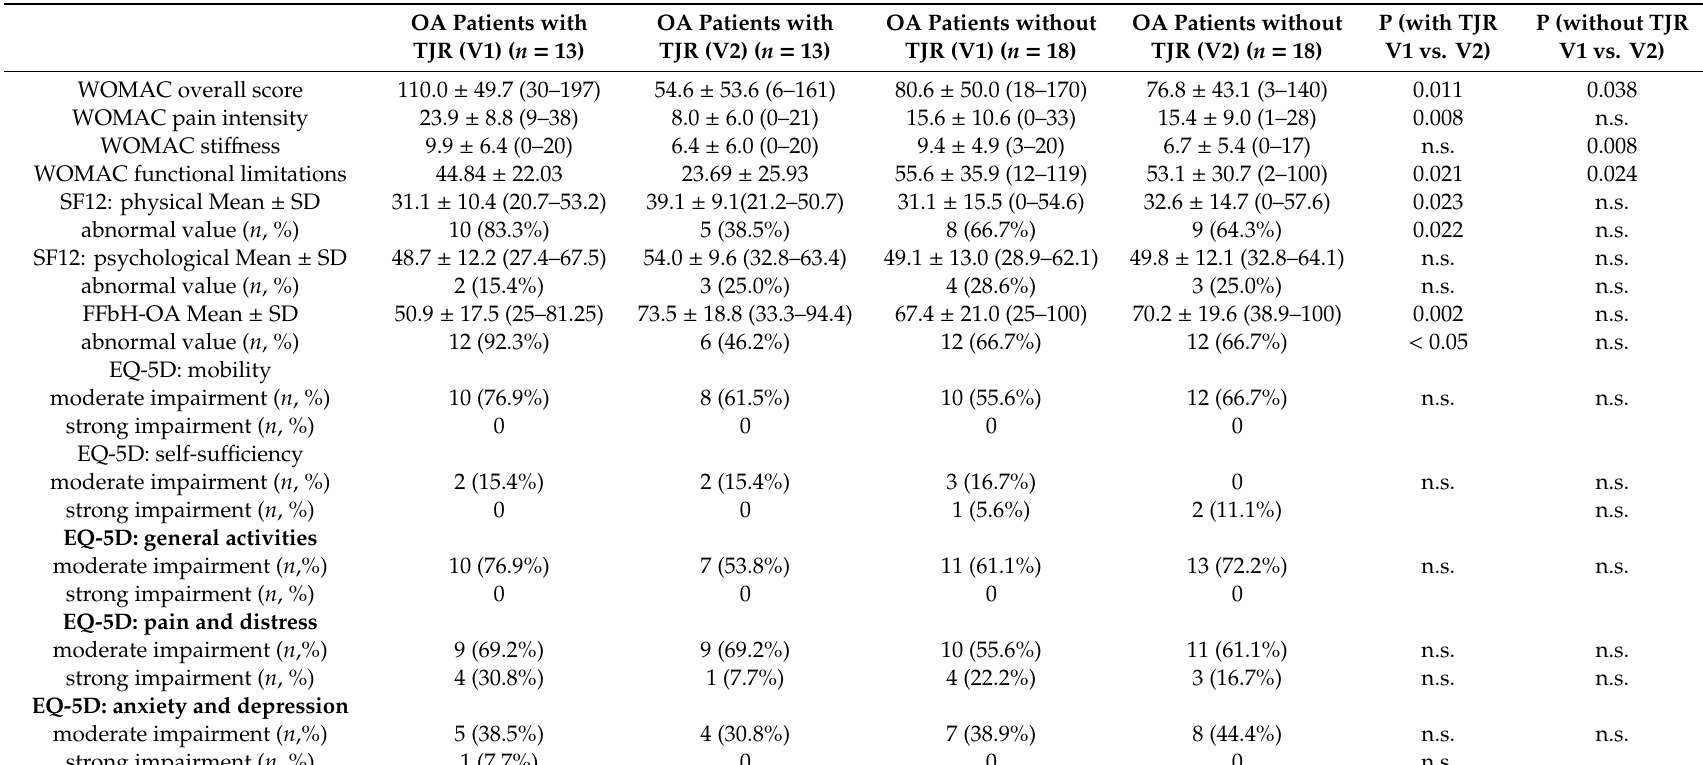
Table 2. Results of